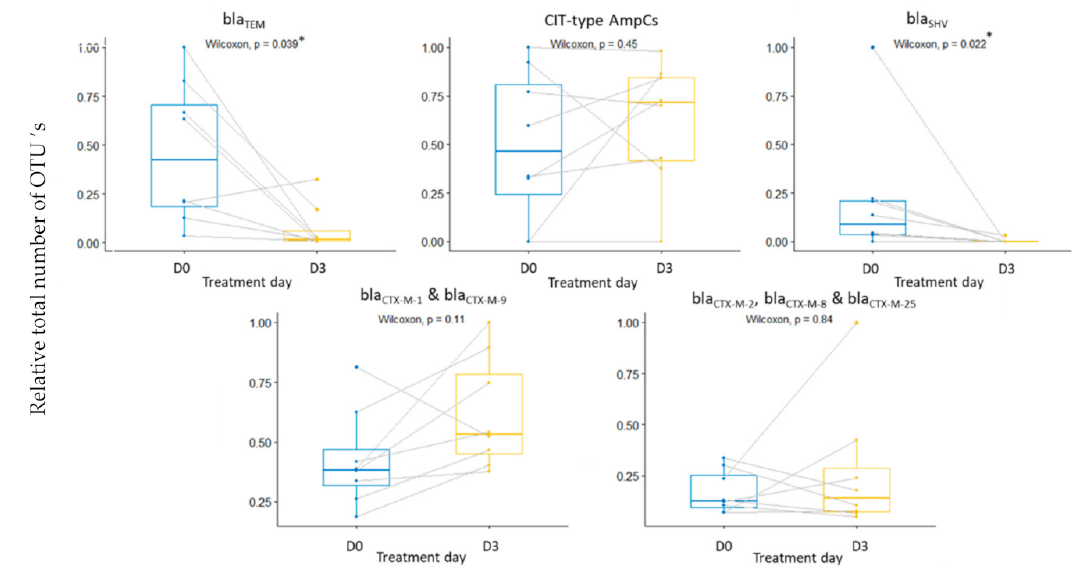
Figure 6. Box-and-whisker plots showing the mean ( n = 8) relative number of selected resistance genes pre-treatment (D0) and post-treatment (D3), i.e., 9 h after the last dose of the daily intramuscular administration of 3 mg · kg − 1 body weight of ceftiofur for 3 consecutive days. Boxes represent the interquartile ranges, the median is depicted by the lines inside the boxes, the whiskers represent the 25% quantile or the 75% quantile plus 1.5 times the interquartile range. Significance codes: ‘*’ p -value <